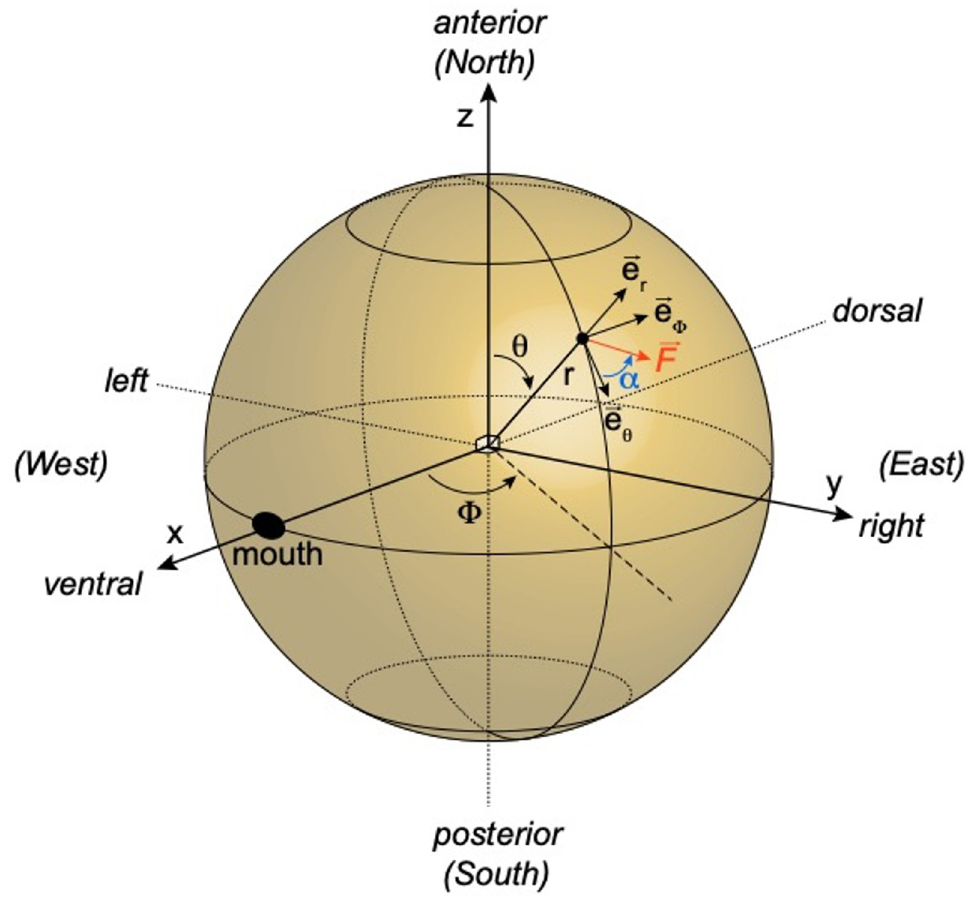
Fig 12. Conventions on the spherical model, with spherical coordinates and a local force F on the surface of the sphere. anterior part, then in the posterior part, then in the right anterior part. The swirling pattern suggests that the cell is going to turn around an axis tilted from the main axis, in the plane sep- arating the left and right sides, and this can be confirmed analytically. In this configuration, the sphere does not move along the main axis ( v = 0 mm/s), because the net force along that axis is null, but it turns along an axis tilted by θ � 34˚ from the main axis. The sphere also spins about 4 times faster ( ω /(2 π ) � 7.2 Hz)–this is of course qualitative since Paramecium is not a sphere. It returns to moving forward when all cilia revert back (Fig 8F, fourth column). This pattern of ciliary reversal is suggested on Fig 2C. However, given that the particle flow was measured on a plane ~30 μ m above the cell, that the cell could take different shapes and that the position of the oral groove was often difficult to estimate, it was generally not possible to determine the precise pattern of ciliary reversal empirically. Nevertheless, it is possible to demonstrate that cilia revert asynchronously. We measured particle flow separately in two regions of the field, beyond the anterior end, and beyond the posterior end (Fig 8G). This was only possible for 9 cells, where video quality was sufficient (see Methods, Particle image veloci- metry ). We measured the mean angle α of the flow field during stimulation with current pulses between 1 nA and 5 nA; weak pulses were not included because particle density tended to be lower due to sedimentation (weak pulses were recorded after strong pulses).